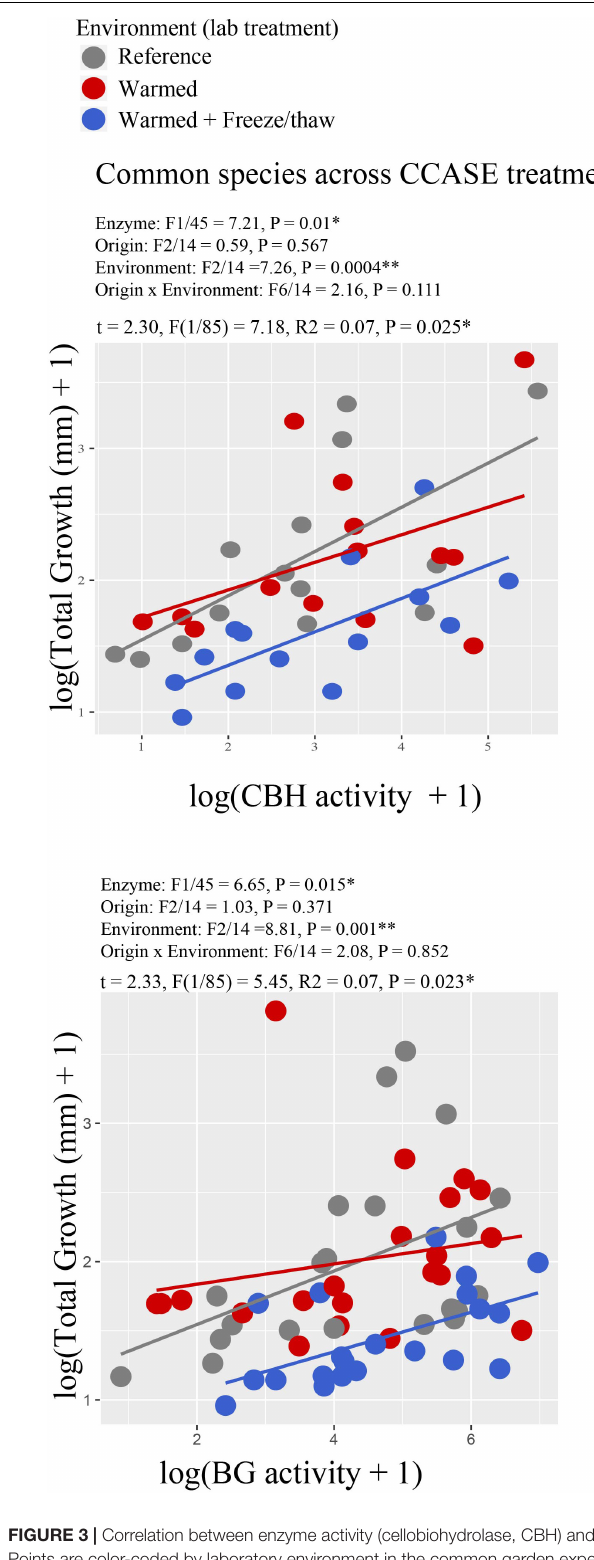
Frontiers in Forests and Global Change |